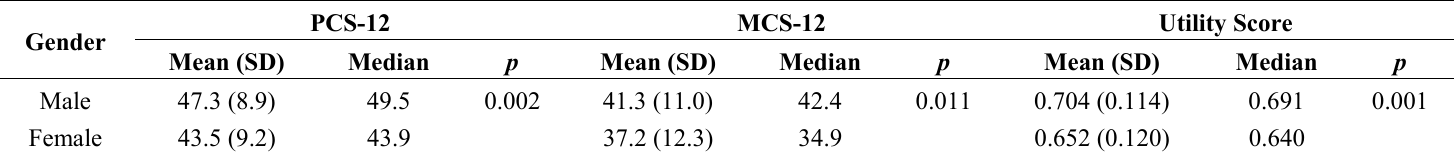
Table 2. HRQoL and utility scores in the Patient-MD group by gender ( N = 203).